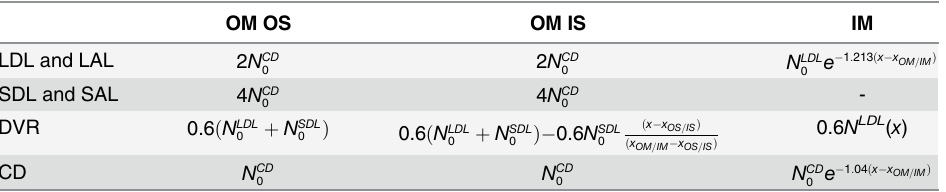
Table 4. Number of tubes at each depth x